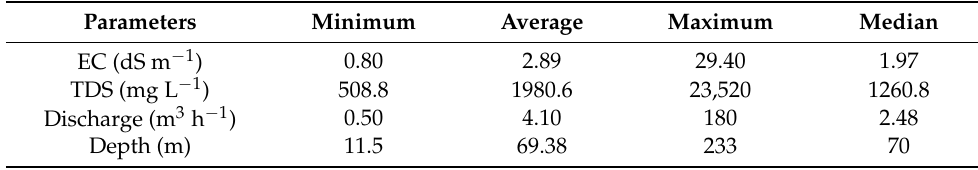
Table 1. Minimum, average, maximum, and median values for electrical conductivity of water (EC), total dissolved solids (TDS), discharge rate, and depth of the 6284 wells with brackish water from the Cear á State